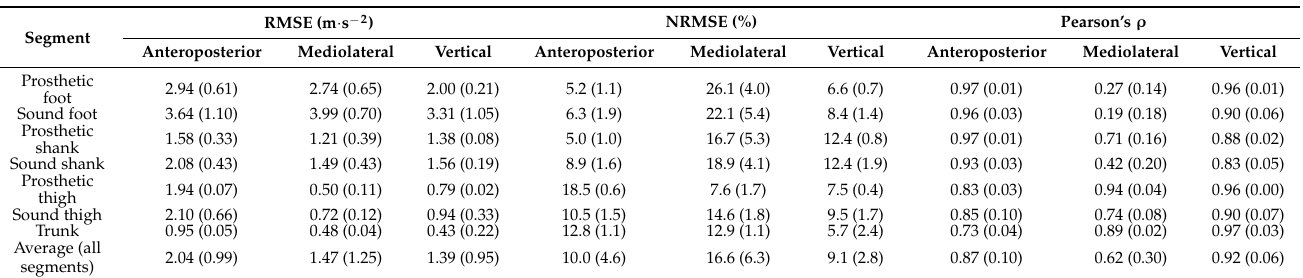
Table 2. Accuracy of segments’ center of mass accelerations estimated with MIMU compared to the optical motion capture reference in terms of root mean square error (RMSE), normalized RMSE and Pearson’s correlation coefficient ( ρ ). Means (standard deviations) over the considered stride cycles are reported.